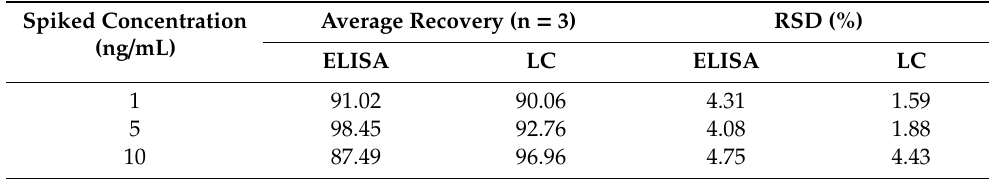
Recoveries of the dinotefuran in enzyme-linked immune assay (ELISA) and liquid chromatography (LC)